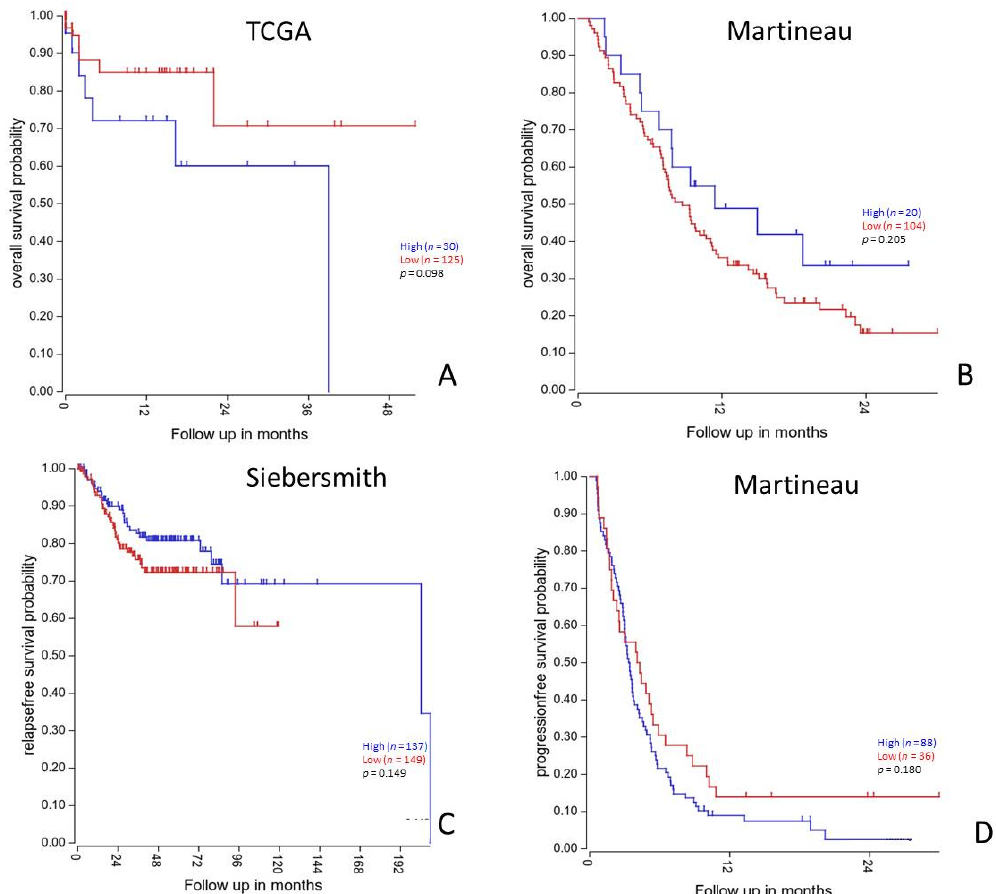
Figure 4. Survival analysis according to DDR1 mRNA expression profile in independent colorectal cancers patients’ cohorts. Kaplan-Meier curves of overall survival ( A , B ) and relapse or progression free-survival ( C , D ) probability for low (red line) and high (blue line) DDR1 mRNA expression in all stages colorectal cancers patients and in stage IV (metastatic) patients ( C , D ). Survival analysis and Kaplan Meyier curves of the TCGA, Martineau and SieberSmith gene expression dataset were obtained from R2 platform (http://r2.amc.nl; last access date: 5 November 2021). All p -values were calculated using R2 online tools.